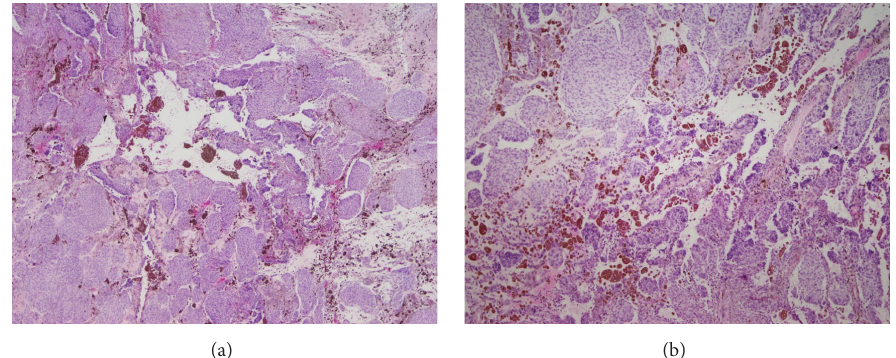
Figure 2: A central part of pigmented lesion with cystic degeneration, small foci of hemorrhage (a), and multinucleated cells that are a common finding in cellular blue nevus (b).